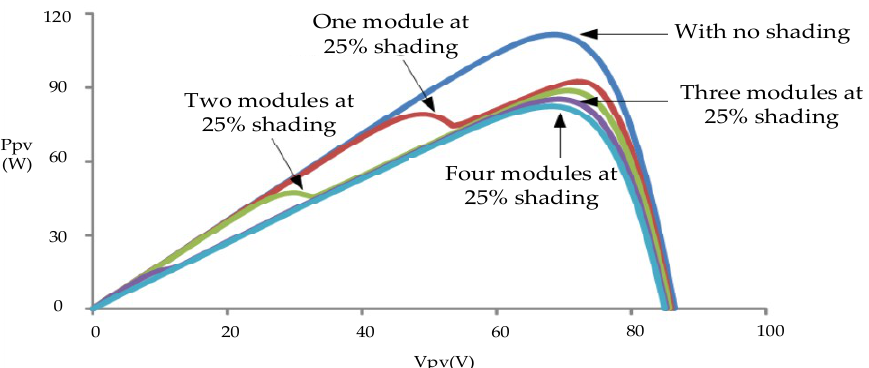
Figure 2. Simulated P–V characteristic curve when different modules in the four-series and one-parallel connected module array have 25% shading.